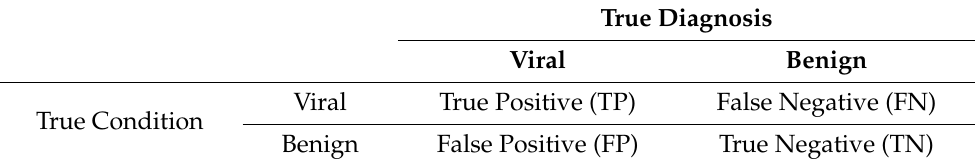
Table 7. Confusion Matrix.